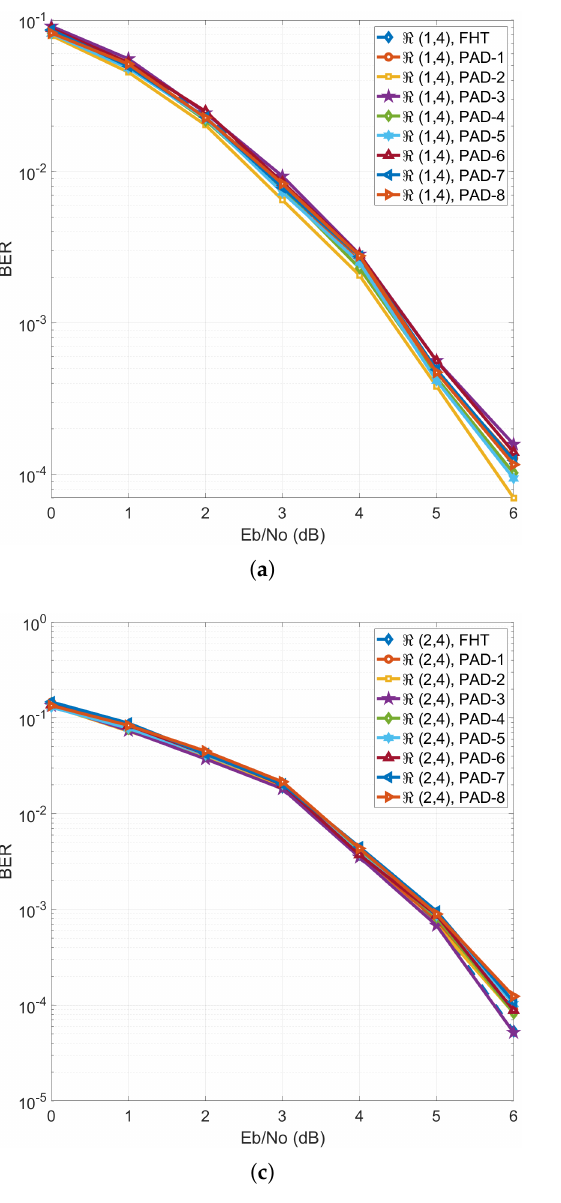
Figure 7. BER of RM decoding with FHT and